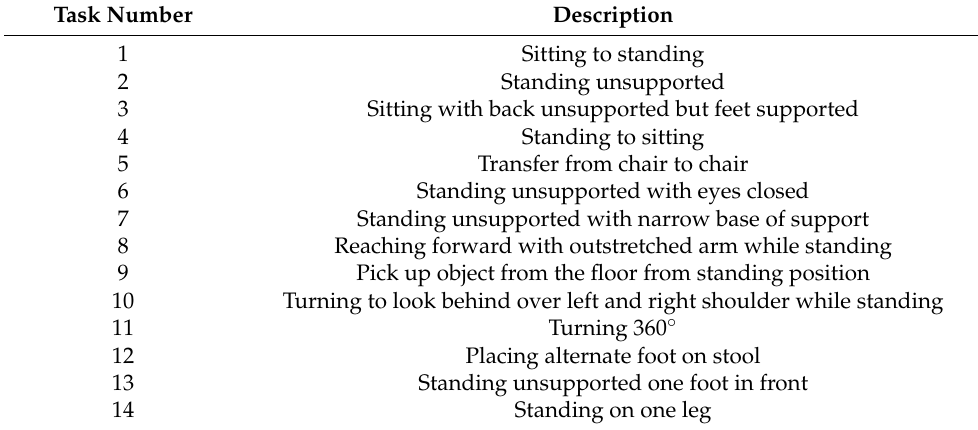
Table 1. The 14 tasks in the Berg Balance